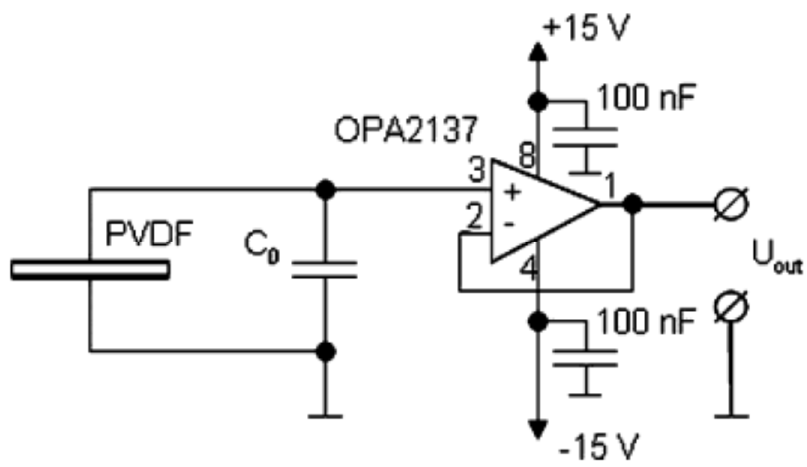
Figure 3. Voltage follower employed to measure the charge generated by a PVDF foil, reprinted from [29] with permission from Elsevier.